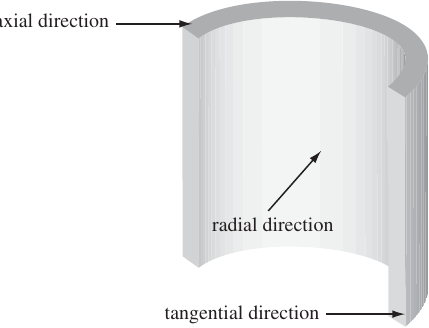
Figure 1. Schematics of a cylinder liner a section, where the used directions for the Laue photograph are